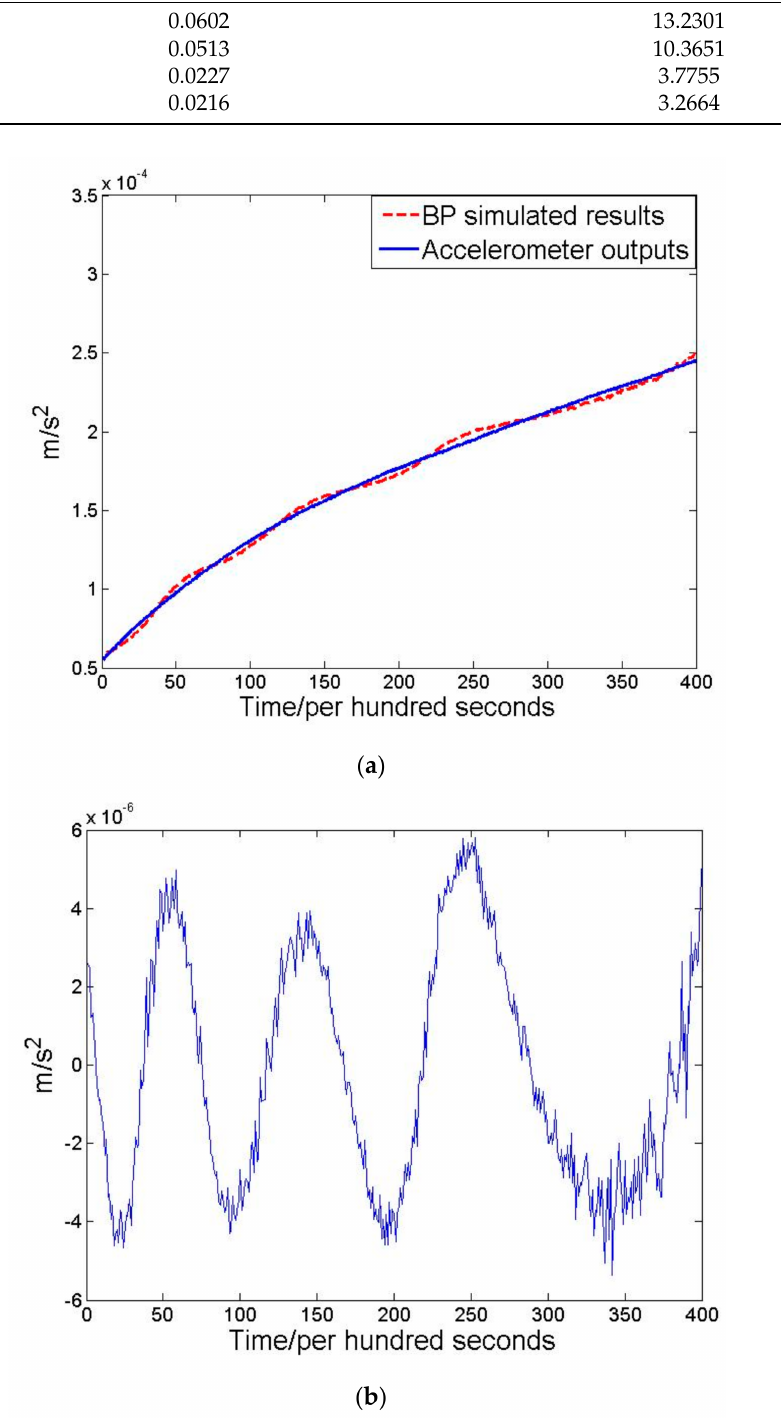
Figure 3. ( a ) The mean value per hundred seconds of accelerometer outputs and ( b ) the mean value per hundred seconds of accelerometer